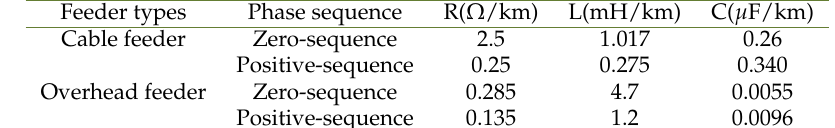
Table 3. Parameters of the feeder